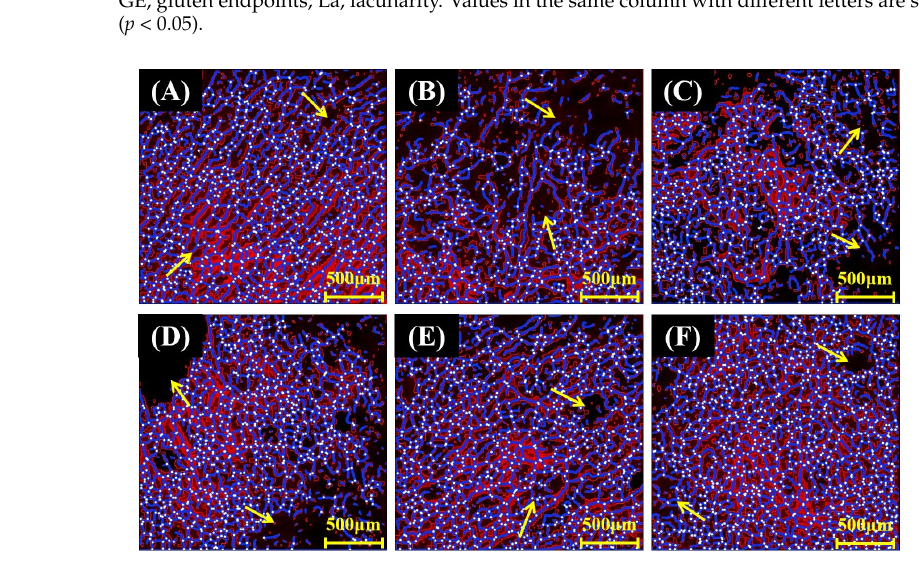
Figure 3. Images of CLSM analysis of noodle gluten network made of highland barley powder with different particle sizes processed by AngioTool software (with junctions shown in white, gluten skeleton shown in purple); WFN ( A ), RFN-1 ( B ), RFN-2 ( C ), RFN-3 ( D ), RFN-4 ( E ), RFN-5 ( F ). The yellow arrows in the figure represent the gaps of gluten. Table 7. Quantitative analysis of the gluten network in the different RFN samples determined by AngioTool software.